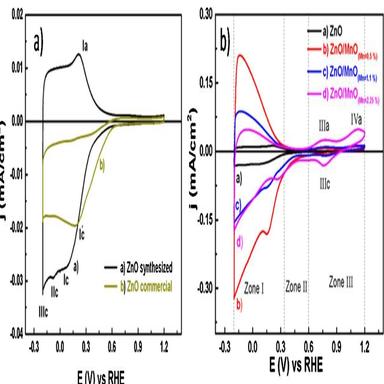
A) Cyclic voltammograms at third cycle of a) synthesized ZnO and b) commercial ZnO. v = 50 mVs−1 in 0.1 M NaOH. B) Cyclic voltammograms for ZnO/MnO nanocomposite with Mn = 0.5%, 1.1% and 2.25% (third cycle). Recorded at v = 50 mVs−1 in 0.1 M NaOH. A RHE and a GCE electrode were used as reference and counter electrode, respectively.